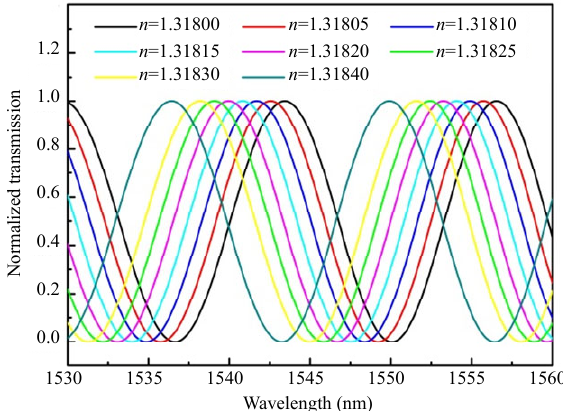
Fig. 6. Transmission spectra of the designed MZI sensor with L = 1.1100 cm for different refractive indices of the tested liquid.